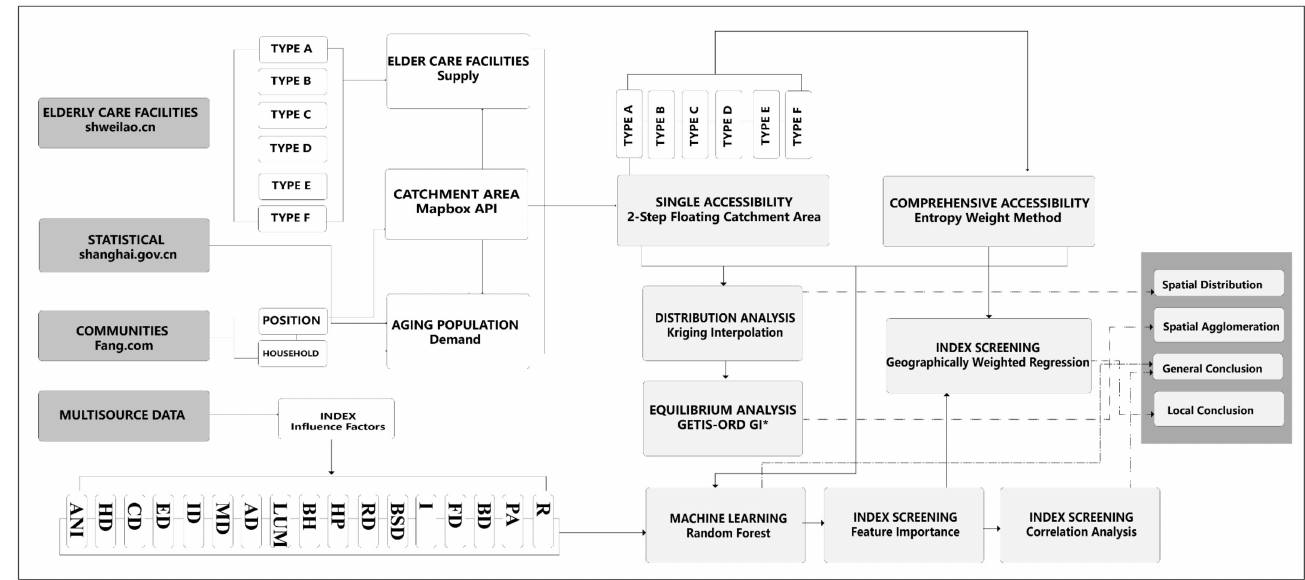
Figure 1. Research Framework.